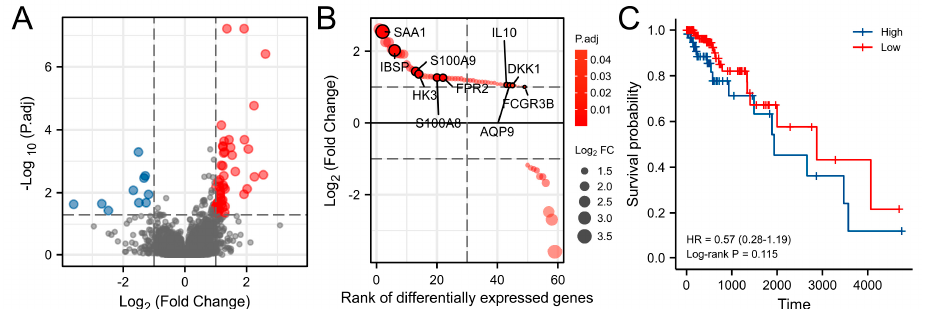
Figure 1. Differences in survival time and gene expression between the two groups. ( A ) Differentially expressed genes (DEGs). Genes with increasing expression were represented in red, whereas genes with decreased expression were represented in blue. ( B ) Ranking plot of DEGs. ( C ) Kaplan–Meier curves for the two groups.